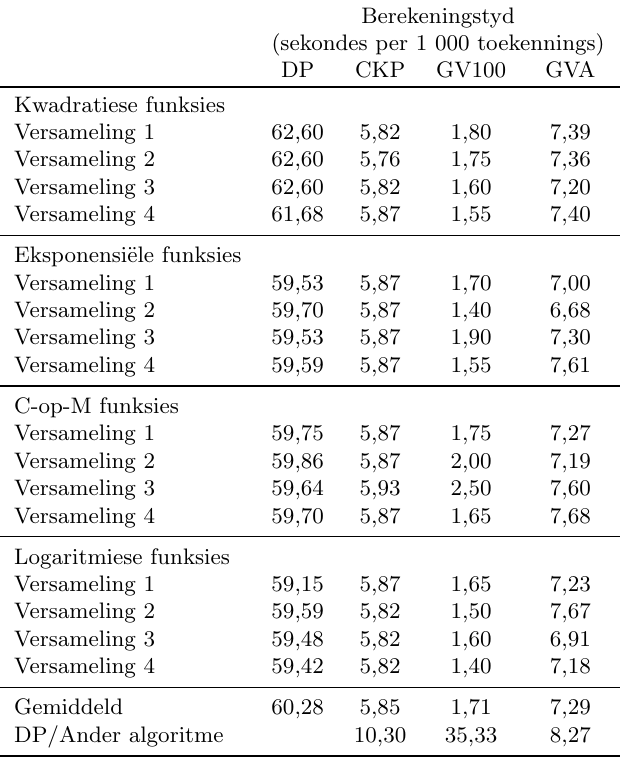
Tabel 1: Berekeningstyd vir verskille algoritmes.